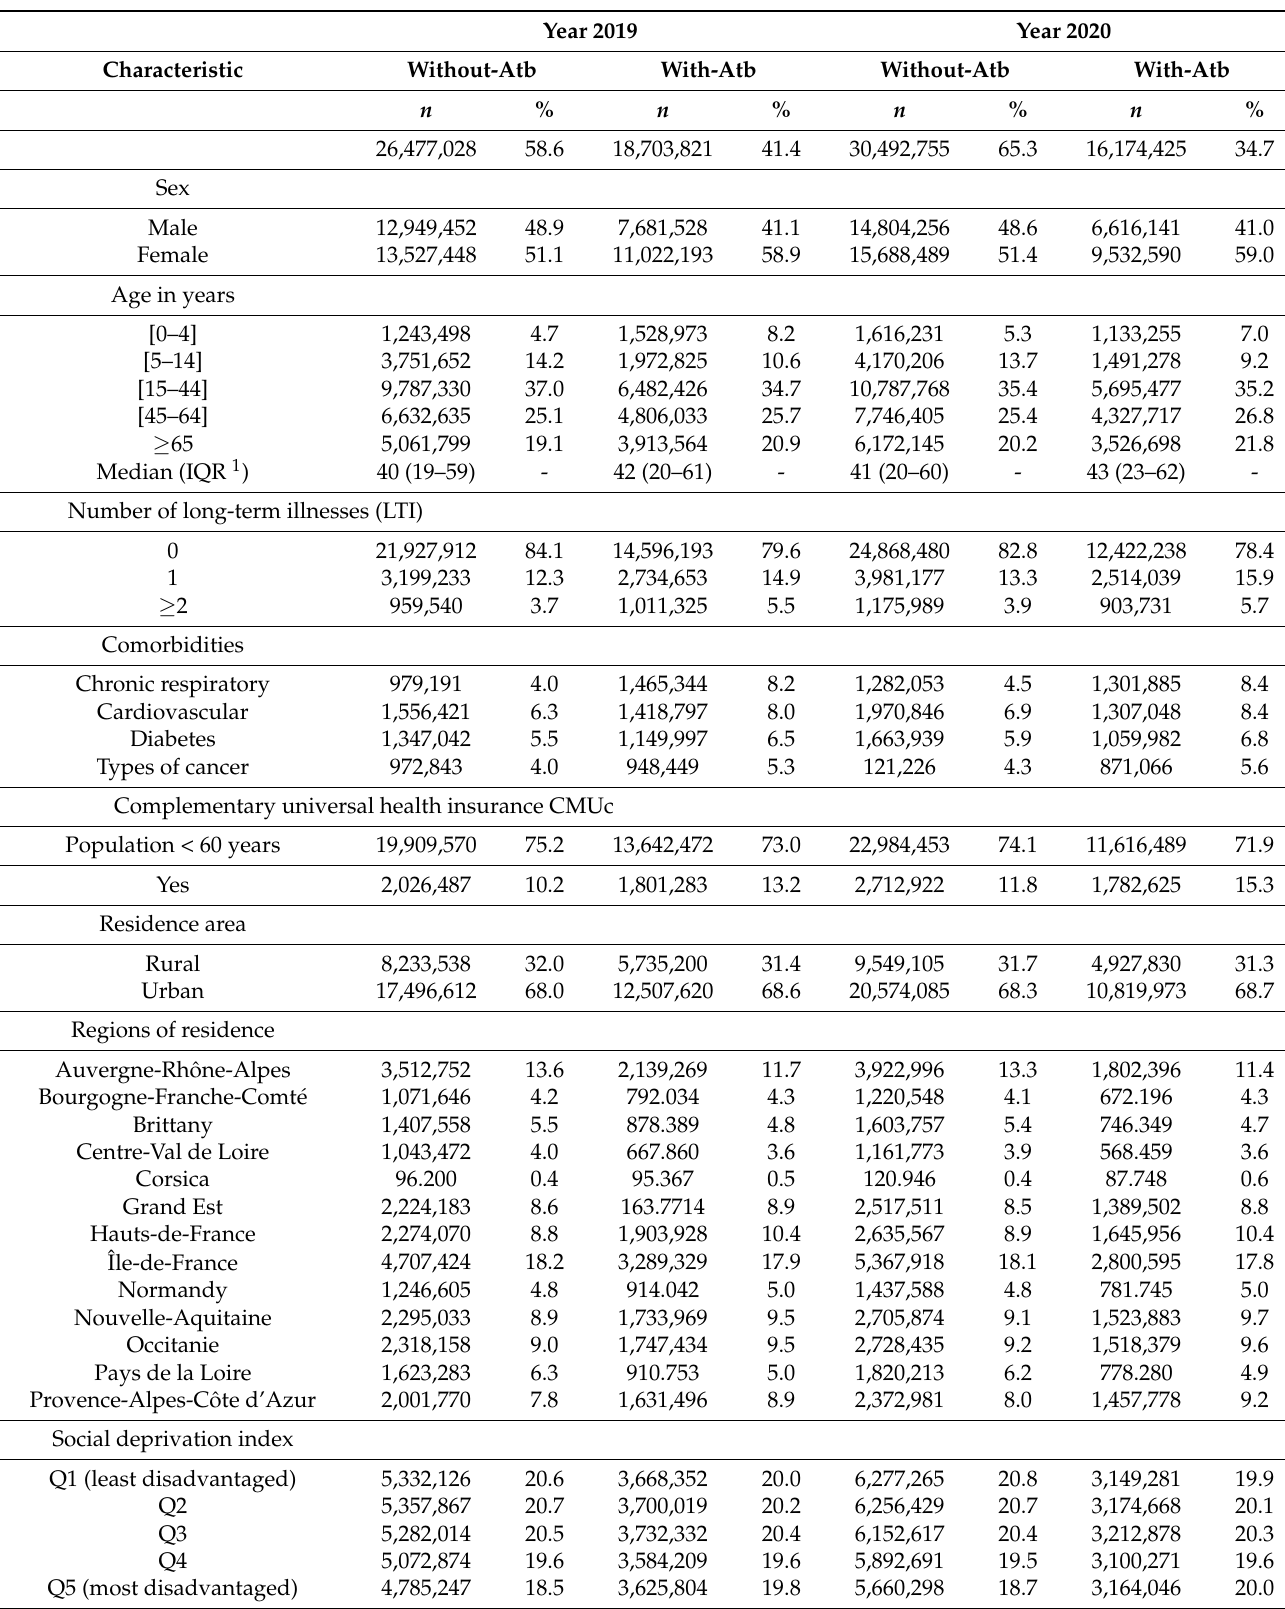
Table 1. Socio-demographic characteristics of patients with (With-Atb) or without (Without-Atb) at least one antibiotic prescription reimbursement, 2019 and 2020,